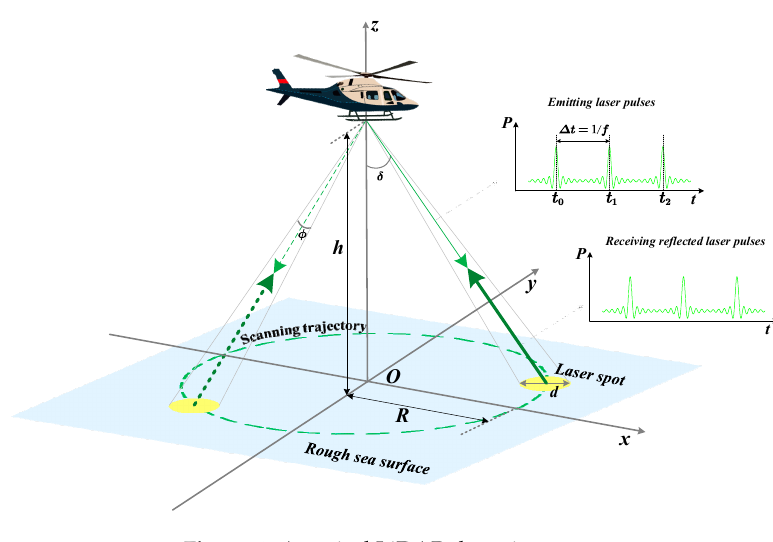
Figure 4. A typical LiDAR detection scene.